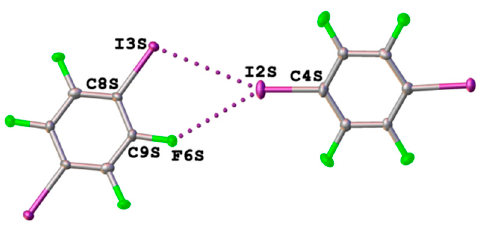
Figure 2. The C–I ··· N XBs in anastrozole (ASZ) · 1.5( 1,4-FIB ). Hereinafter noncovalent interactions Figure 2. The C–I···N XBs in anastrozole (ASZ) ·1.5( 1,4-FIB ). Hereinafter noncovalent interactions were assigned by dotted lines and ellipsoids are drawn with 50% probability. were assigned by dotted lines and ellipsoids are drawn with 50% probability.